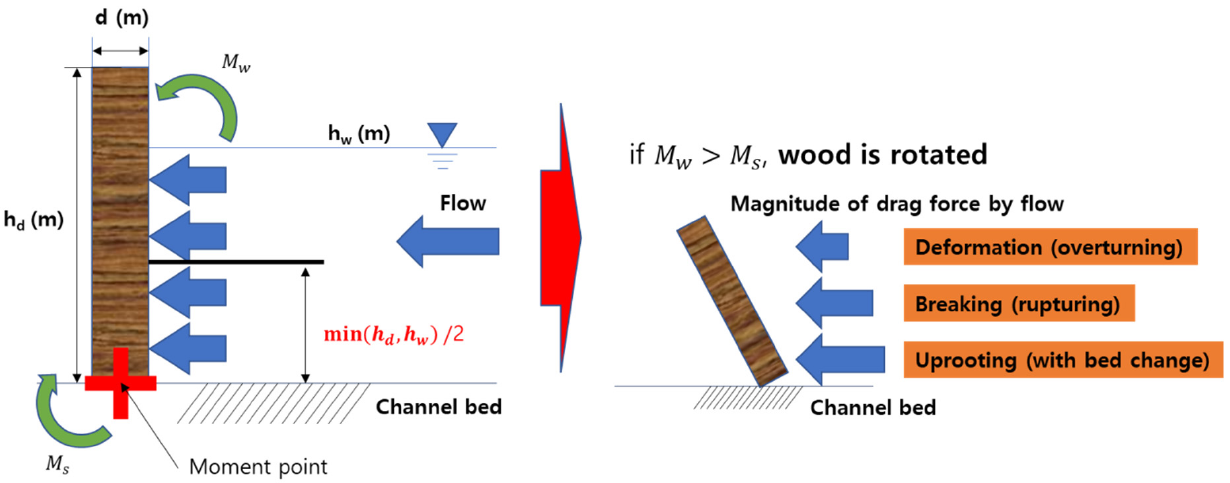
Figure 2. Driftwood generation model ( M s is critical moment of perpendicularly cantilevered wood; M w is moment acting on the stem of the wood body).